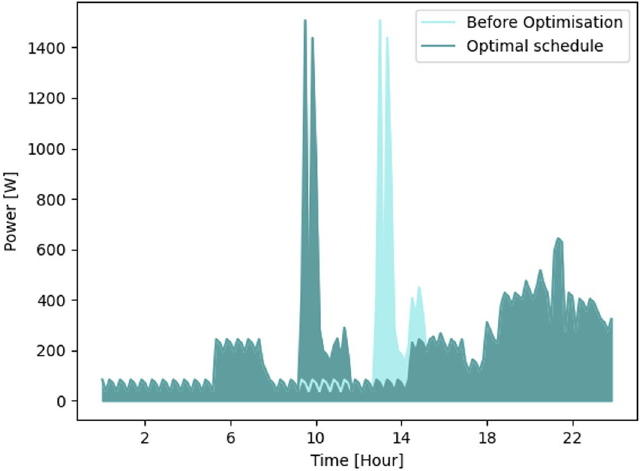
Fig. 6 Example of optimal scheduling for a single household in the Case study